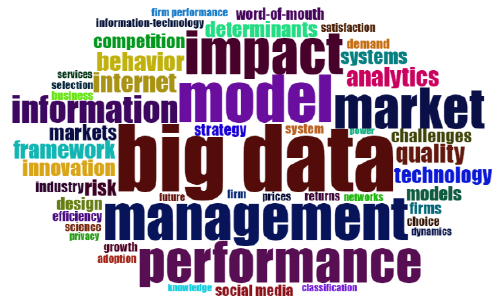
Informatics 2021 , 8 , 74